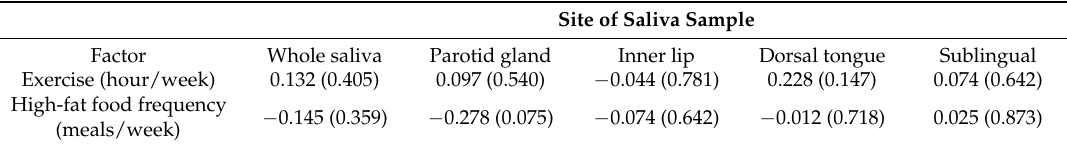
Table 2. Summary values from Spearman r analysis to assess the correlation between the relative activity and selected lifestyle